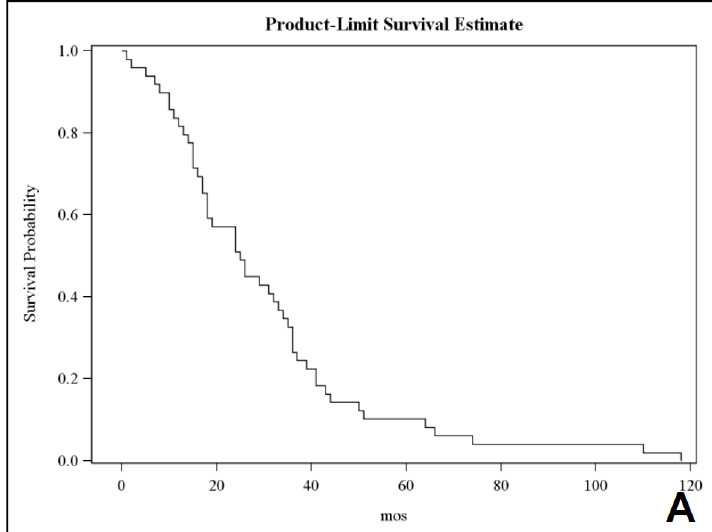
Figure 2. Overall survival of the whole study population ( A ); Survival postneurosurgery; ( B ) BM HER-2 0 (score 0/1+) vs. 1 (score 2+/3+); Survival